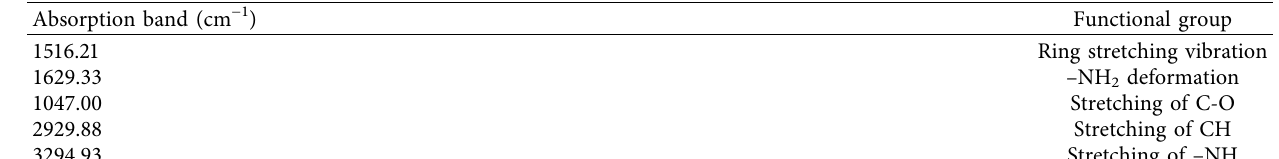
Table 2: The FT-IR spectrum’s absorption bands and their functional groups.